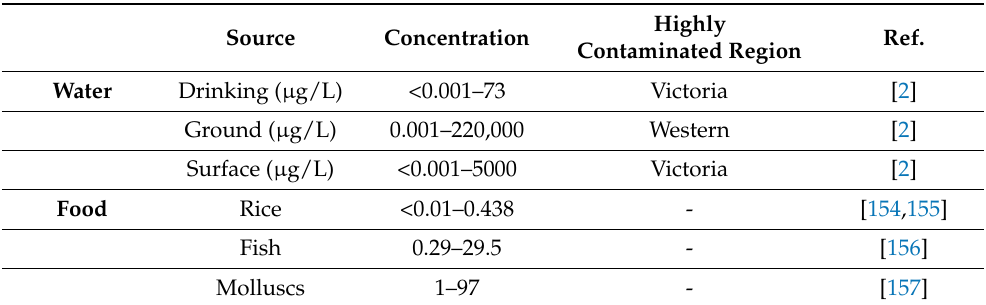
Table 7. Concentration of arsenic in water and foods in Australia and New Zealand (selected data from the recent literature).